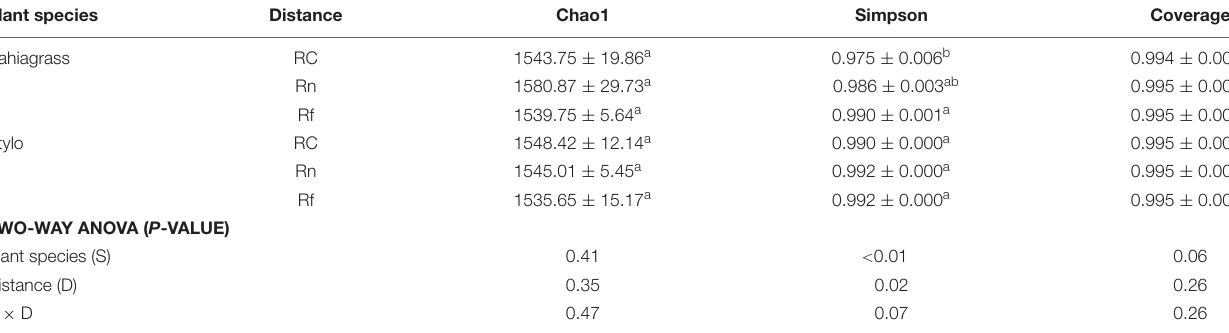
TABLE 1 | Soil bacterial community structure as affected by plant species and distance. Plant species Distance Chao1 Simpson Coverage Bahiagrass